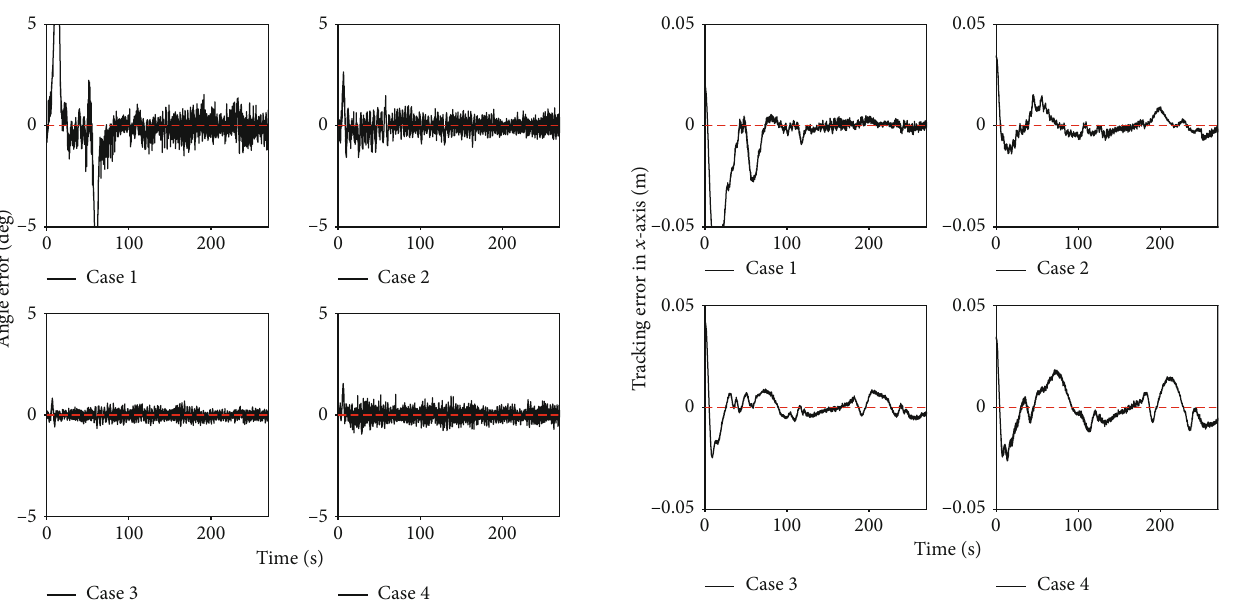
Figure 3: Experimental result: angle errors.